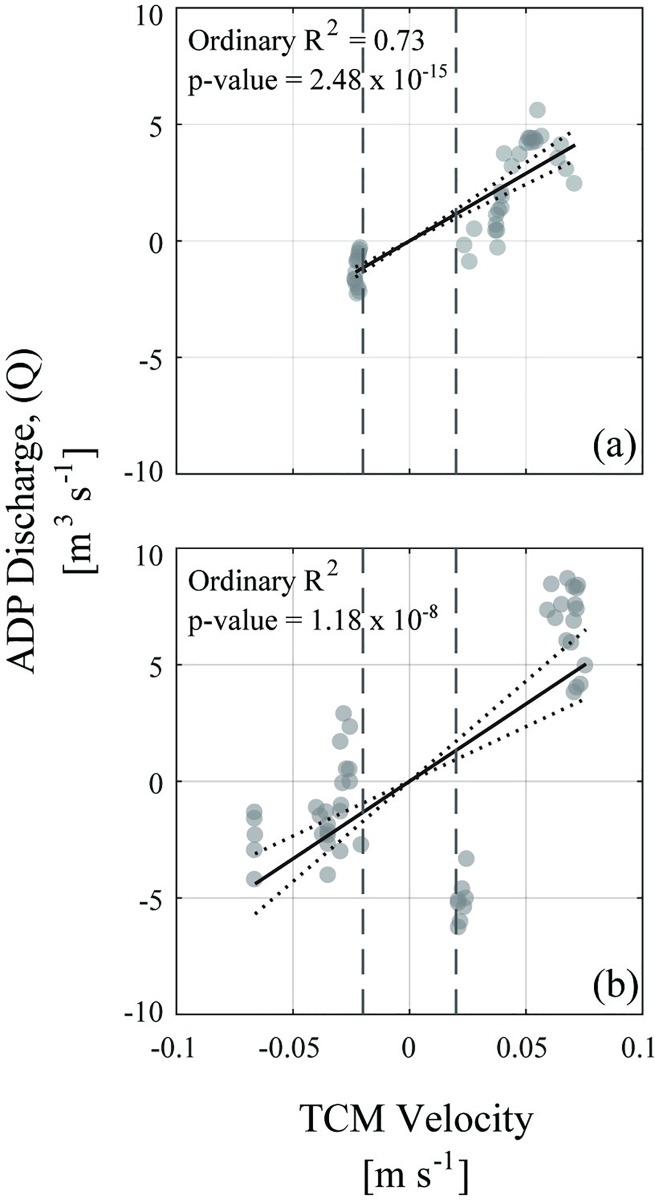
Example regressions of tilt current meter velocities to ADP-measured discharges.Example linear regressions of tilt current meter (TCM) velocities to ADP-measured discharge at Aransas river sites A3 (a) and A4 (b). Gray dashed lines indicate zone of TCM velocity magnitudes less than the 0.02 m s-1 reliable detection limit. In each figure panel, circles marking empirical observations are transparent; thus, darker circles denote overlap of observations. Dashed lines represent 95% confidence bounds of the regression. Visualization created using MATLAB software.